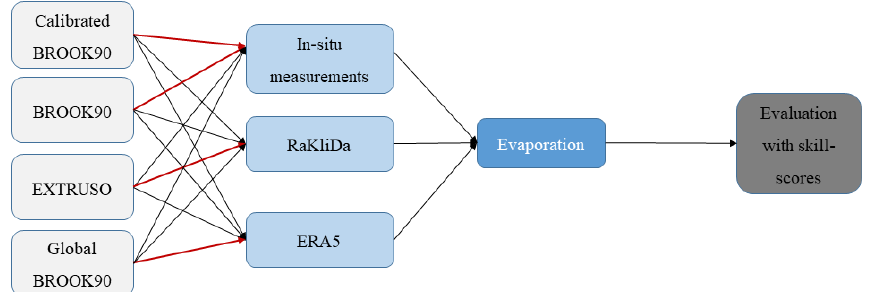
Figure 2. Principal scheme of the framework’s mixture. Red arrows represent the original “parameter set–meteorological forcing” combina-